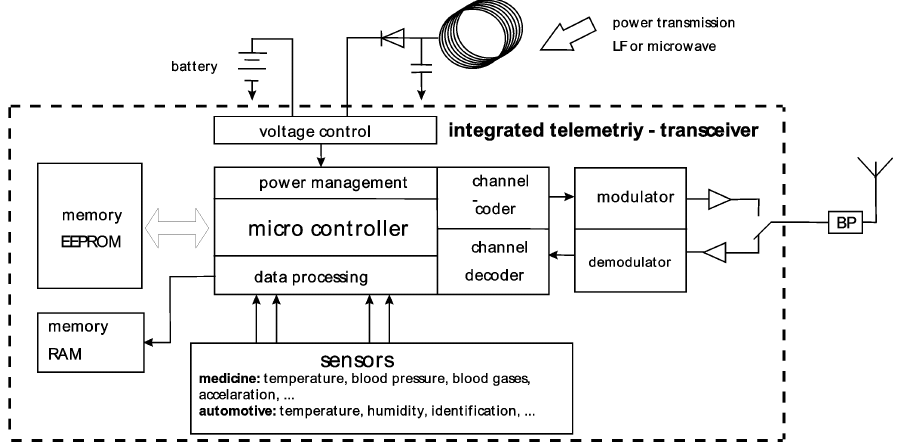
FIGURE 3 Principle diagram of a wireless